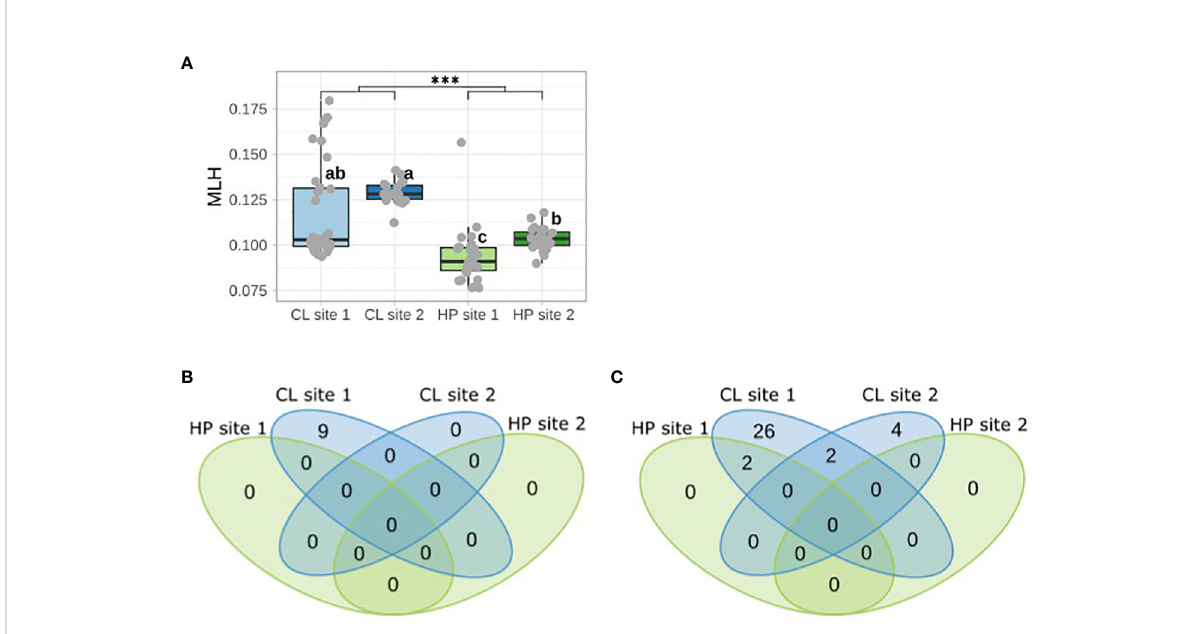
FIGURE 3 (A) Individual multilocus heterozygosity (MLH) per sampling population represented with a Box and Whisker plot. Grey dots indicate MLH per individual. *** indicates a signi fi cant difference among morphs (Kruskal rank sum test, p < 0.001). Lowercase letters indicate signi fi cant differences among sampling populations (pairwise Wilcoxon rank sum test, p < 0.05). (B) Number of fi xed heterozygous sites and (C) almost fi xed heterozygous sites among populations. Almost fi xed heterozygous are sites with >85% of heterozygous sites. HP refers to haplodiplontic, CL to clonal.